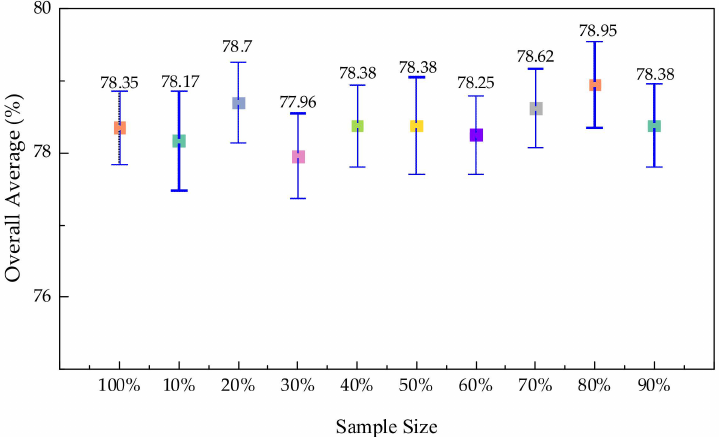
Figure 8. The overall accuracies and confidence intervals of SVM classifier after NKMNF with different proportion sample sizes (number of features = 45) in Xiong’an.